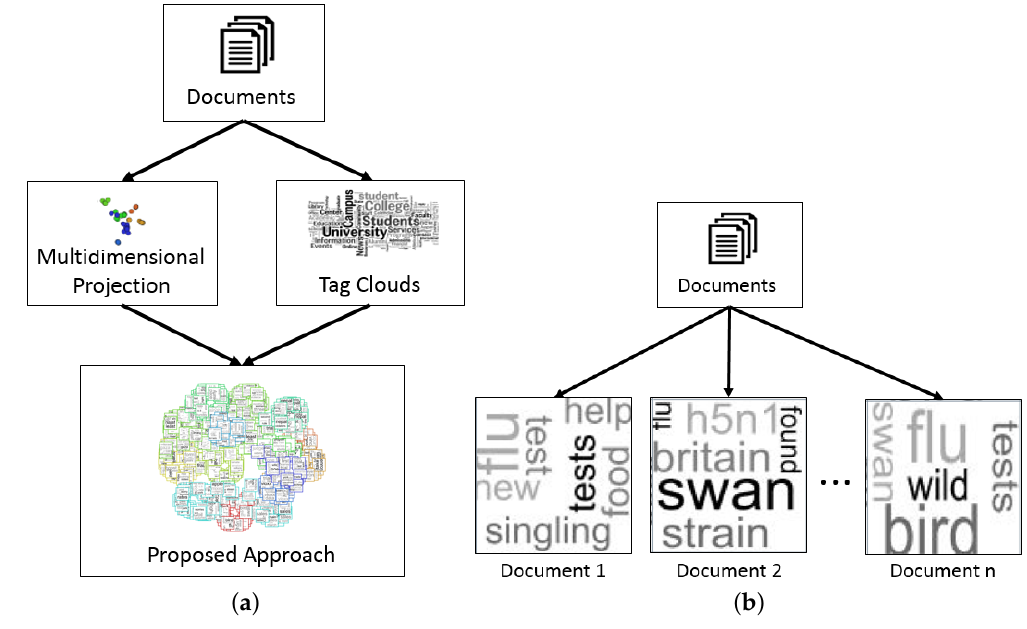
Figure 2. Proposed approach: ( a ) the complete process and ( b ) the detailed process of computing tag clouds for each document.